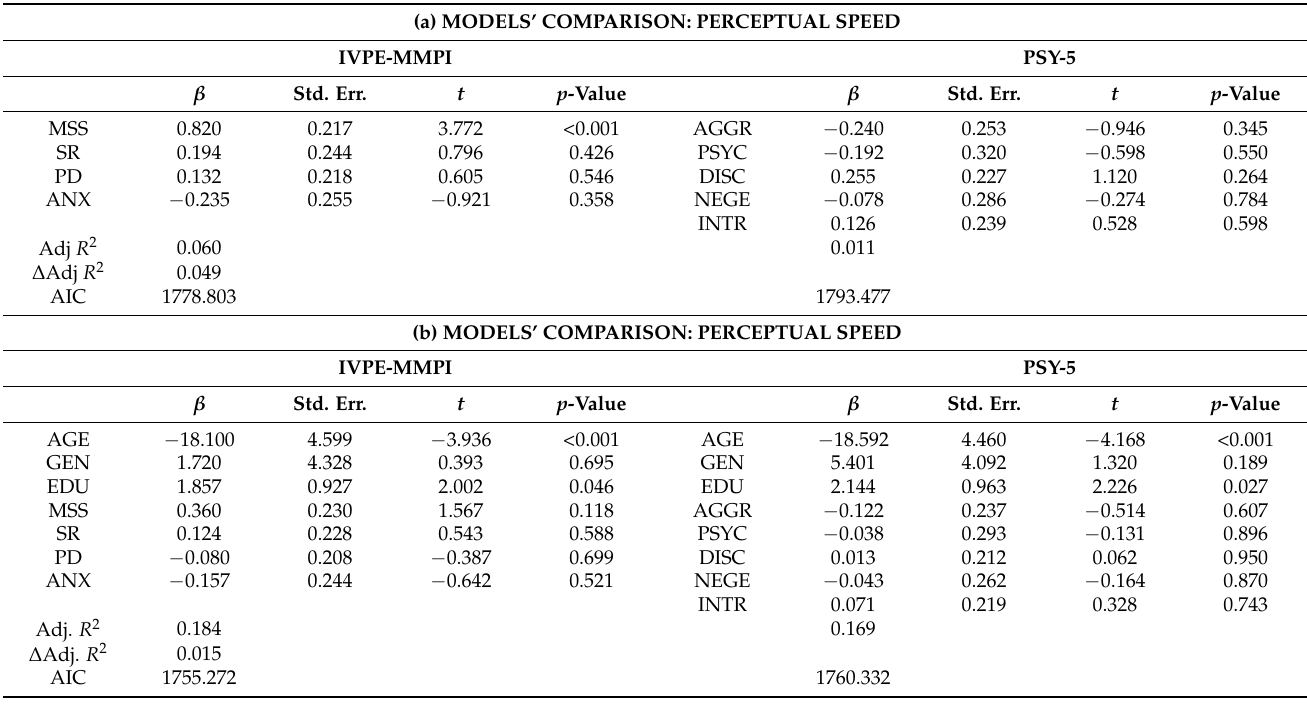
Table 4. Standardized beta coefficients. Standard errors and significance levels for predictors of the Adaptive Tachisto- scopic Traffic Perception Test (ATAVT) variable. Adjusted R 2 and Akaike Information Criterion (AIC) are also reported. Comparisons between models are presented uncontrolling for demographics ( a ) and considering their contribution ( b